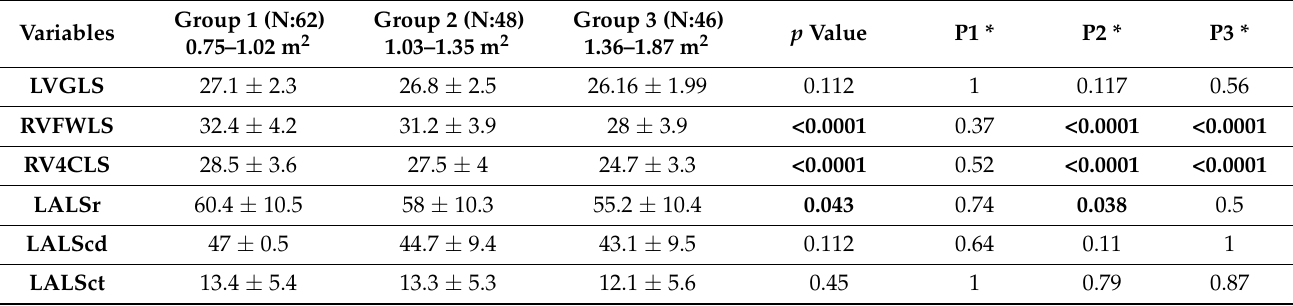
Table 6. Strain values categorized by body surface area